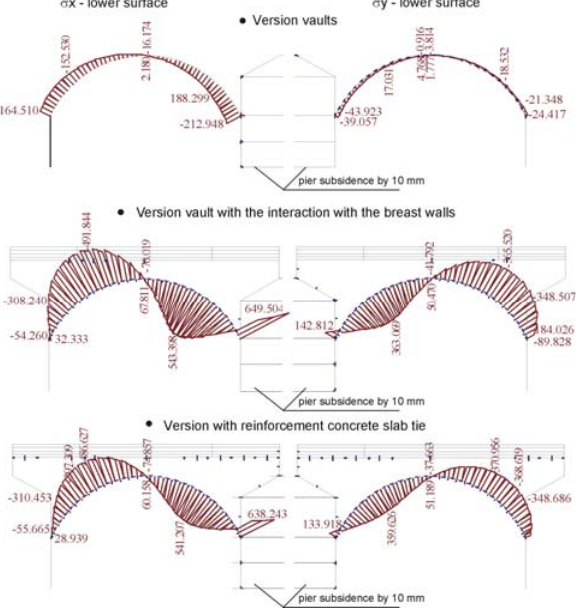
Fig 11. Scheme of course of normal stresses σ x and σ y in longitudinal vault axis at pier subsidence by 10